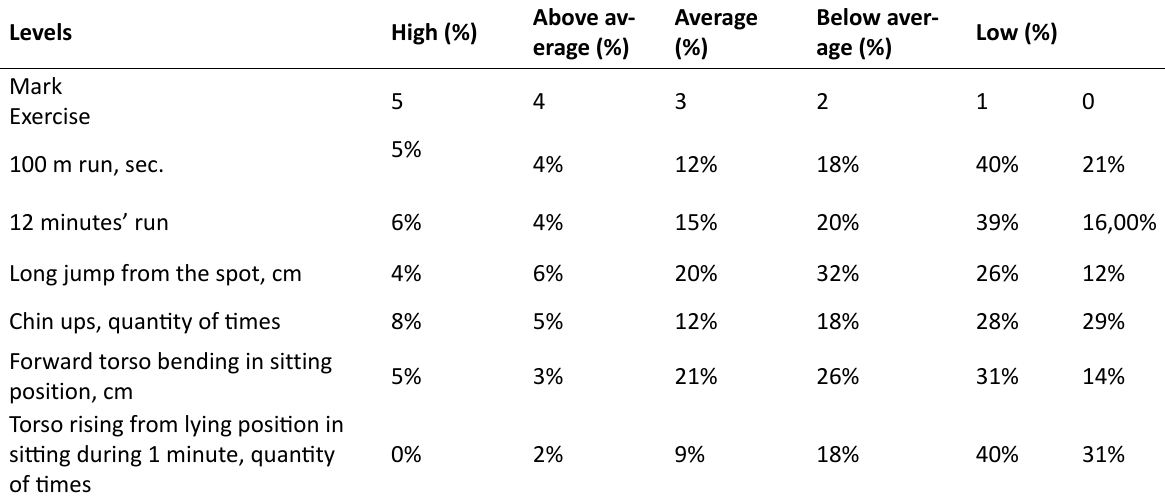
Table 3. Distribution of first year students’ distribution by physical fitness Levels